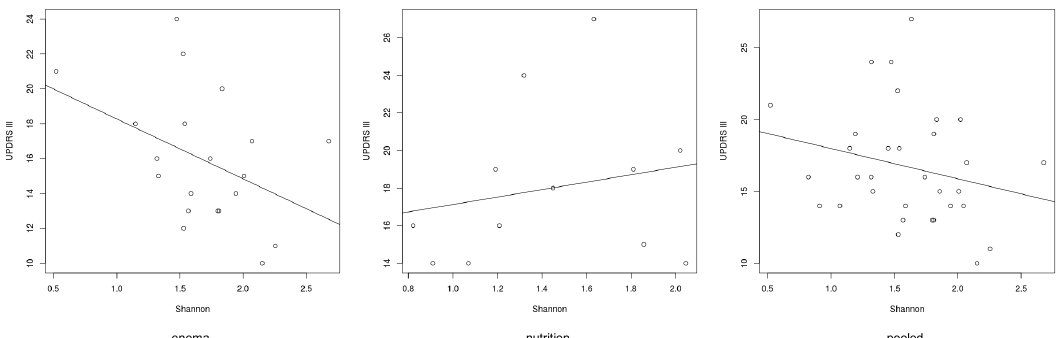
Figure 9. Correlation between the Shannon-Index and the UPDRS III. There was no significant correlation between the Shannon-Index and the UPDRS III but a significant association in the generalized linear model within the pooled group ( p = 0.006).